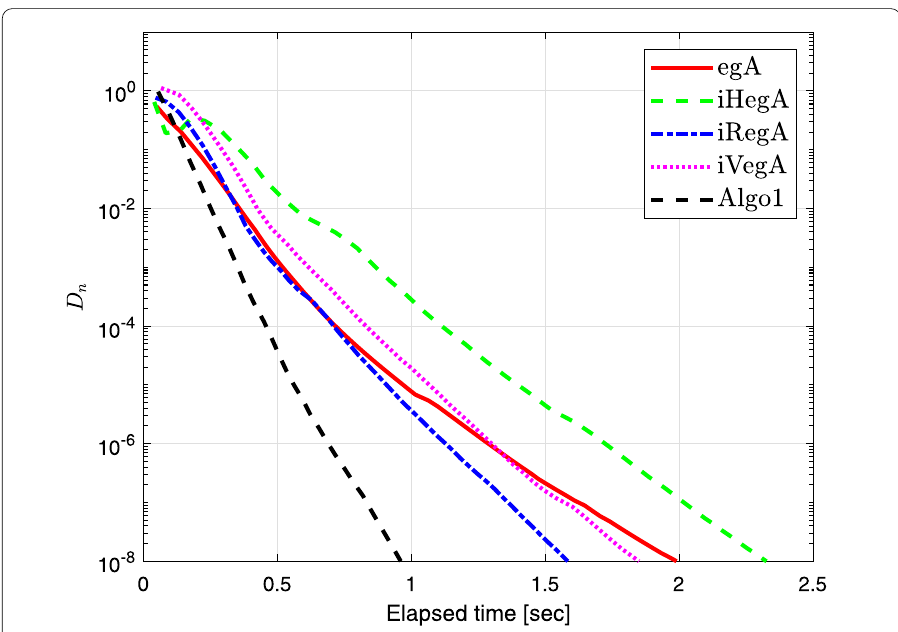
Figure 8 Example 5.3 when x 0 = (1,1,1,1,1) T : the number of iterations is 68, 63, 49, 45, 47, respectively